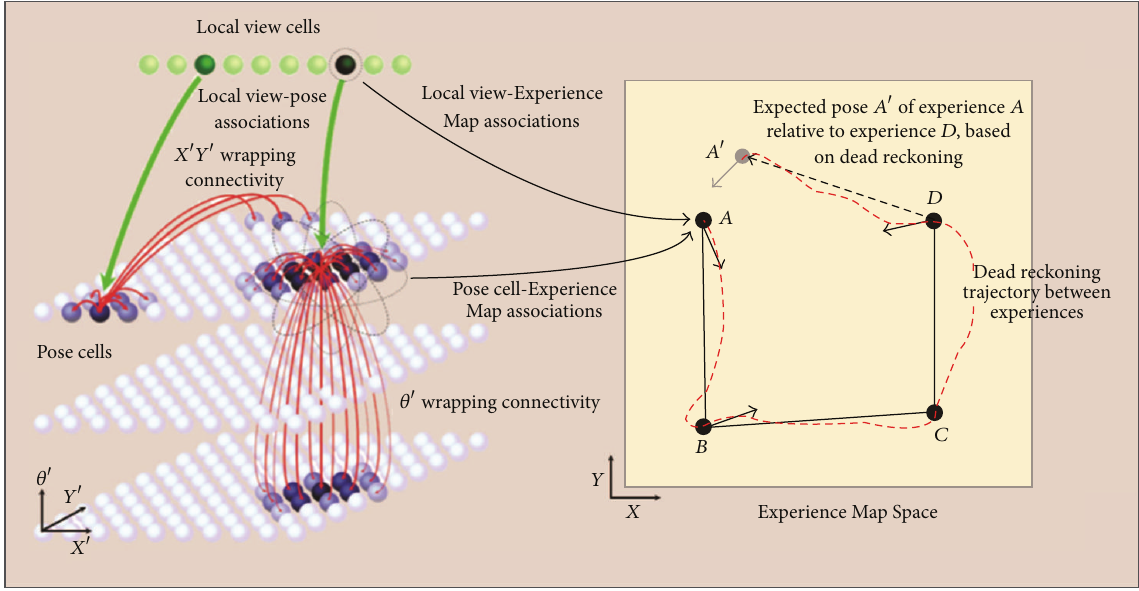
Figure 9: The RatSLAM system. The left side represents the CAN system which forms pose cells from local view cells using a 3D CAN algorithm. The right side represents the Experience Map, which helps disambiguate scenes that are similar in a semimetric form. A further, detailed description can be found [23]. Permission for replication given by Dr. Michael Milford.